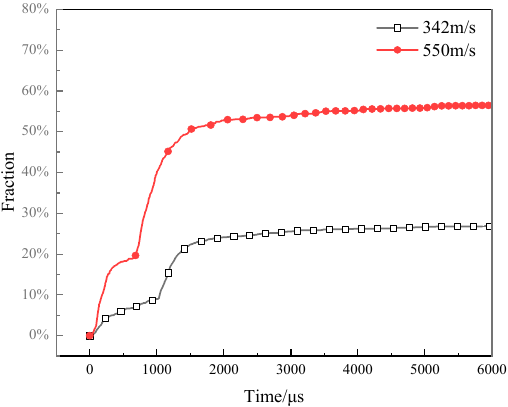
Figure 10. The time-resolved reaction ratio of RMP versus time.